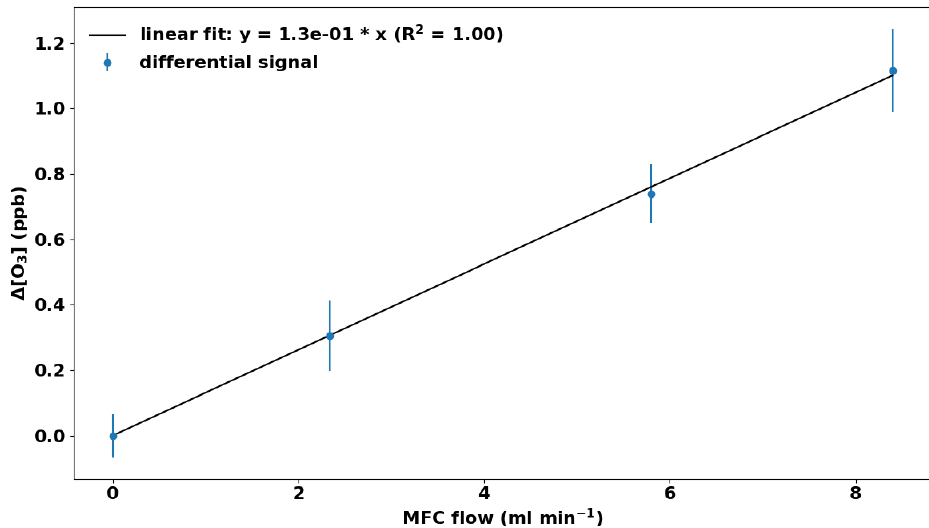
Figure 9. Laboratory test of the TORM. A small flow of a high-mole-fraction limonene standard was fed into the system upstream of the reactor. Error bars represent the standard deviation for the monitoring data at each